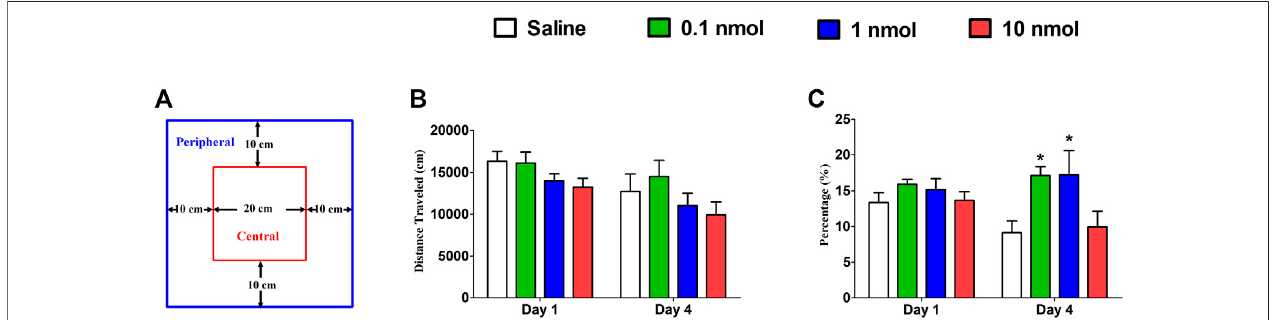
FIGURE8| Effectsof α -conotoxinTxIBinlocomotoractivitytest.Dataarepresentedasthemean ± SEM, n (cid:1) 8 – 10. (A) Schematicdiagramofthelocomotoractivity box. (B) Thedistancetraveledofdifferentgroups on the fi rst and fourth days.ANOVA: Day 1, F 3,34 (cid:1) 1.84, p (cid:1) 0.16; Day 4, F 3,34 (cid:1) 1.26, p (cid:1) 0.30. (C) Thepercentage of the distance in the central area to the total distance of different groups on the fi rst and fourth days. ANOVA: Day 1, F 3,34 (cid:1) 0.93, p (cid:1) 0.44; Day 4, F 3,34 (cid:1) 4.02, p < 0.05. Asterisks represent signi fi cant difference of the saline group (* (cid:1) p < 0.05).